Question: Draft a figure caption describing what is shown.
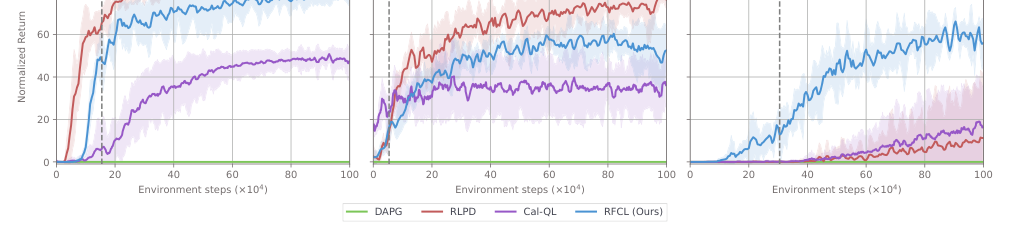
Answer: Adroit Results with random demonstrations. Results averaged over 5 seeds with shaded area repre- senting 95% CIs. Every single seed succesfully finished the reverse curriculum and the success rate (not shown) reached near 100%. The normalized return of RFCL plateaus just below the state-of-the-art method RLPD for the two easier environments, but significantly outperforms RLPD and Cal-QL on the harder Adroit Relocate environment.